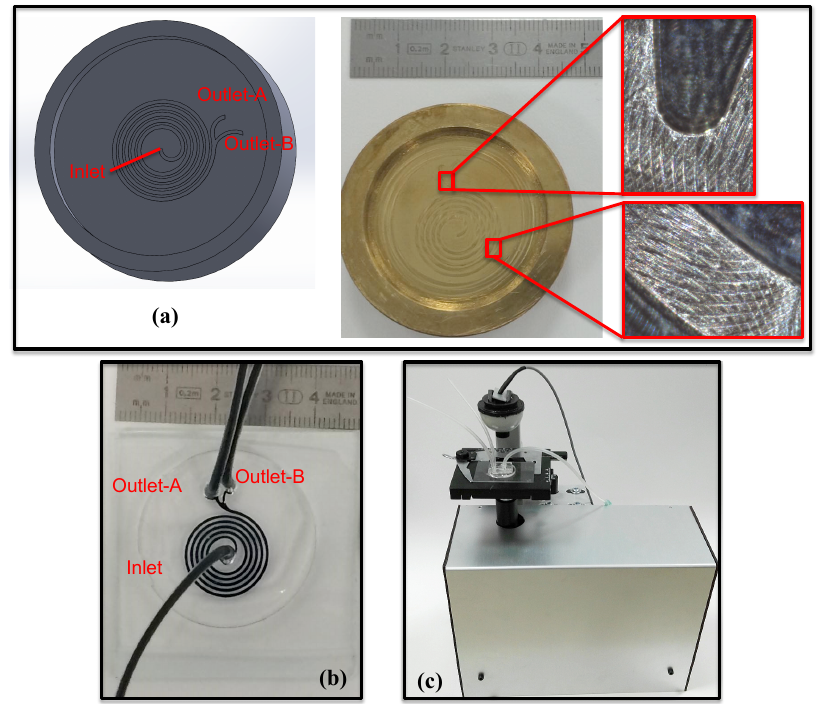
Figure 8. ( a ) Mold of the spiral channel, ( b ) fabricated microfluidic device and ( c ) custom-made epi-fluorescence microscope.